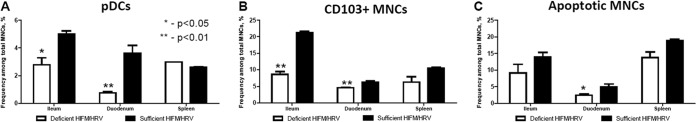
Effects of protein-deficient and -sufficient diets on the frequencies of systemic and intestinal pDCs (A), CD103+ MNCs (B), and apoptotic MNCs (C). MNCs were isolated from the spleen, ileum, and duodenum of the piglets in the four experimental groups at PID14. The frequencies of pDCs (CD172+/CD4+/CD11R1−), CD103+ MNCs, and apoptotic MNCs among the total MNCs were assessed by flow cytometry. Asterisks indicate statistically significant differences (Kruskal-Wallis test; P ≤ 0.05). n = 10/group. Error bars indicate the SEM.